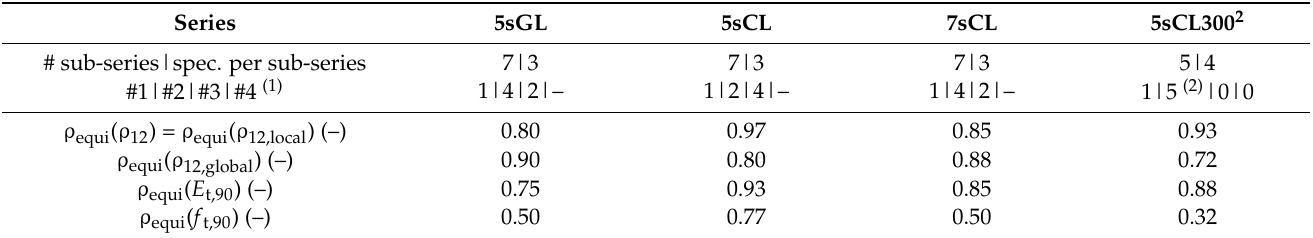
Table 10. Estimates for the equi-correlation coefficients, expressing the variation between board segments within sub-series for series 5sGL, 5sCL, 7sCL and 5sCL300 2 together with statistics on the number of failures in segments of the same board within